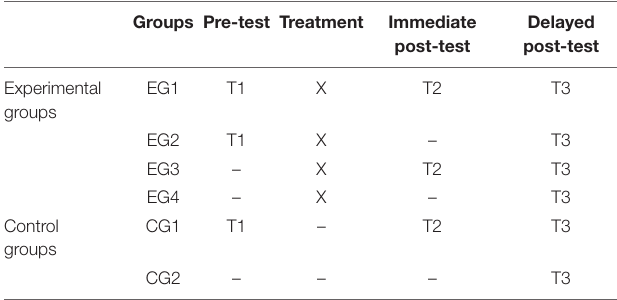
TABLE 1 | Schematic representation of the design of the